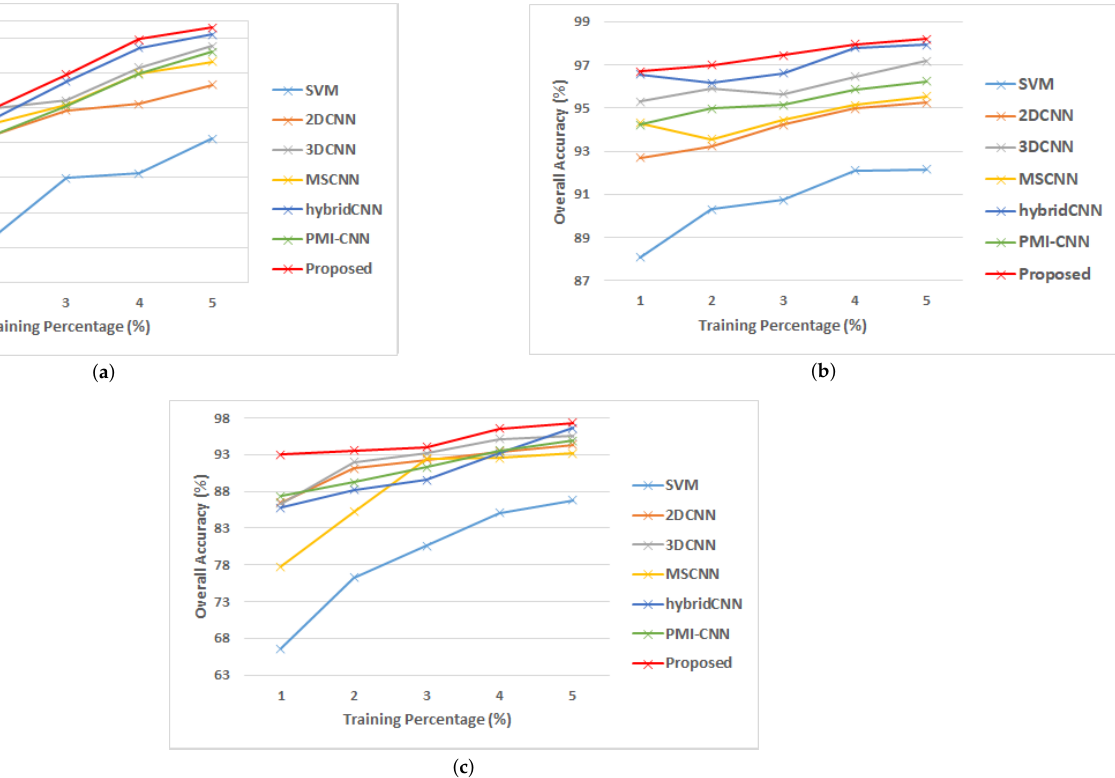
Figure 10. Classification accuracy at different percentages of training data ( a ) PU; ( b ) SA; ( c )